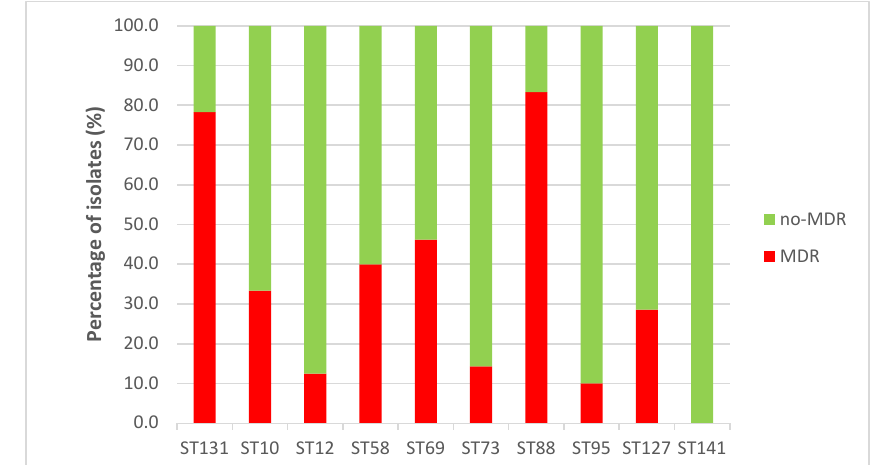
Figure 6. Multidrug resistance (MDR) within dominant sequence types.